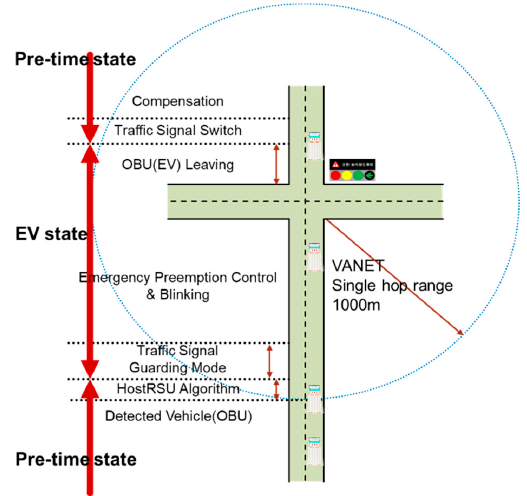
Figure 4. Emergency vehicle signal preemption (EVSP) scenario.